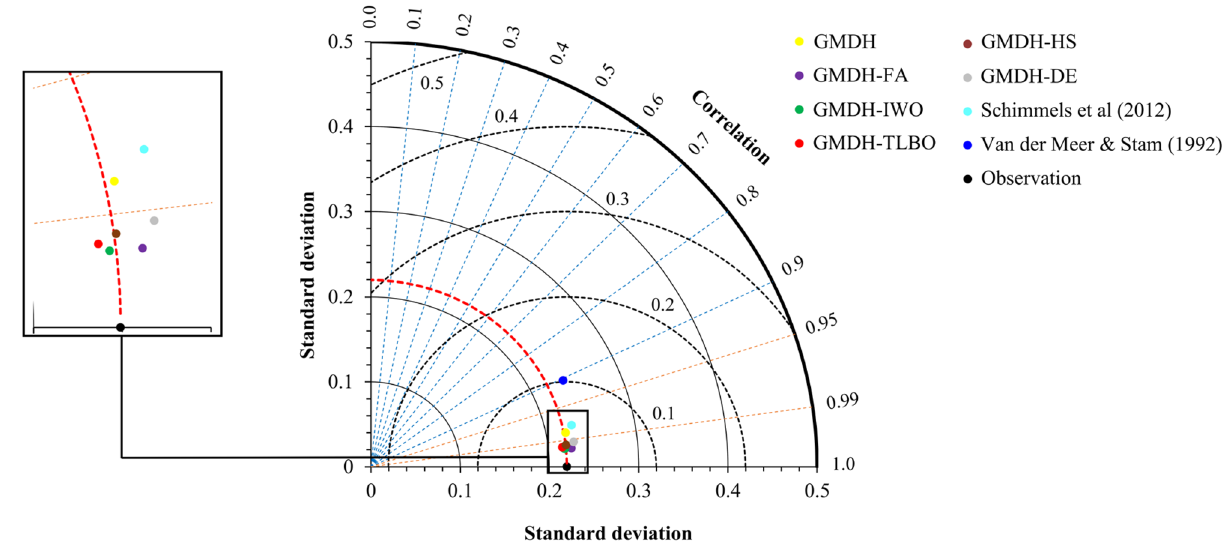
Figure 6. Taylor diagram for the tested data set.